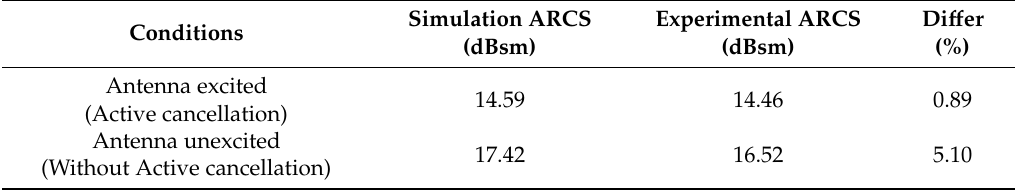
Table 3. The results obtained by the simulation and experiments with di ff erent